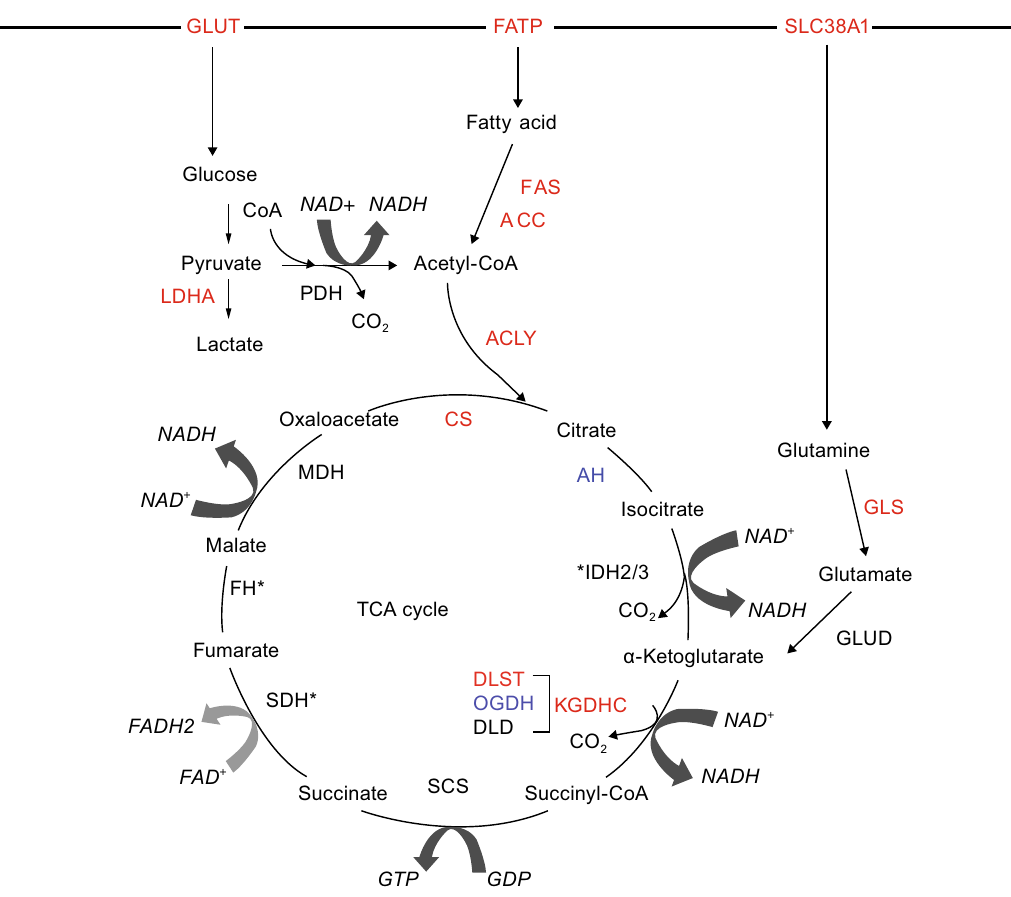
Figure 1. Transporters, fuels, enzymes, and biochemical reactions driving the TCA cycle. The typical input for the TCA cycle is acetyl-CoA, which is derived from pyruvate, the end product of glycolysis. Through a series of redox reactions, chemical bond energy from acetyl-CoA is harvested to produce high-energy electrons, which are carried to the electron transport chain by nicotinamide adenine dinucleotide (NAD + ) and fl avin adenine dinucleotide (FAD). Subsequent oxidative phosphorylation results in the production of adenosine triphosphate (ATP) from each acetyl-CoA. Because oxygen is required to regenerate NAD + and FAD, the TCA cycle only proceeds in aerobic environments. There are a total of 8 steps in the TCA cycle, three of which are irreversible; the generation of citrate from oxaloacetate and acetyl-CoA by CS; the conversion of isocitrate to α -KG by IDH3; and the formation of succinyl-CoA from α -KG by KGDHC (Berg JM, 2002; Akram, 2014). The biochemical reactions in the TCA cycle are regulated by several means including substrate availability, product inhibition, and allosteric regulation, allowing the cell to control energy production based on its energy status (NADH/NAD + ratio, ATP availability) and nutrient availability (Berg JM, 2002). Intermediates in the cycle can be derived from outside sources, such as the production of acetyl-CoA from β -oxidation of fatty acids or the production of α -KG from protein catabolism, particularly glutaminolysis (Houten and Wanders, 2010; Akram, 2014). Importantly, deregulation of TCA cycle enzymes, such as mutations and gene deregulations, or aberrant accumulation of TCA intermediates can have disease-relevant consequences. Proteins that are upregulated in cancer are highlighted as red and downregulated as blue, while enzymes mutated are marked with an asterisk. Abbreviations: CS: citrate synthase, AH: aconitase, IDH: isocitrate dehydrogenase, KGDHC: